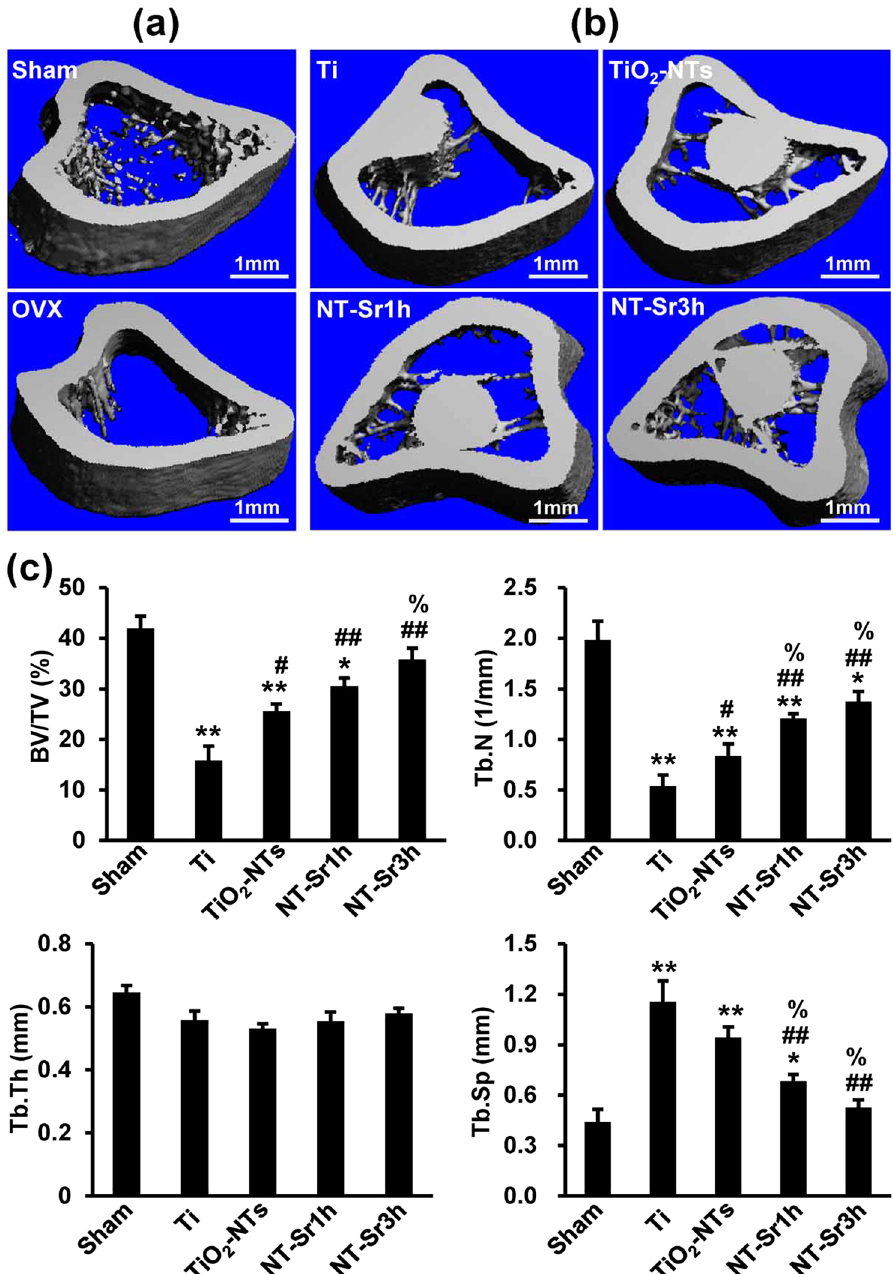
Figure 8. NT-Sr inhibit OVX-induced partial loss of bone mass. ( a ) Micro-computed tomography ( µ CT) images of the proximal tibia from sham and OVX groups. ( b ) µ CT images of the proximal tibia from the different implants groups. The scale bar represents 1 mm ( a , b ). ( c ) BV/TV, Tb.N, Tb.Th, and Tb.Sp were analysed. * , ** p < 0.05 and 0.01, respectively, compared with the sham group, #,## p < 0.05 and 0.01, respectively, compared with the Ti group, and % p < 0.05 compared with TiO 2 -NTs. The data are presented as the means ± SDs with n = 12 per